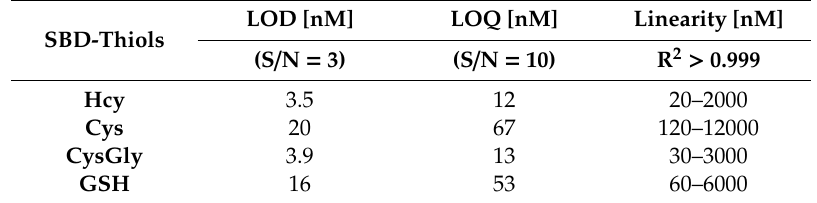
Table 1. Limits of detection (LOD), limits of quantitation (LOQ), and linearity for SBD-thiols. LOD [nM] SBD-Thiols